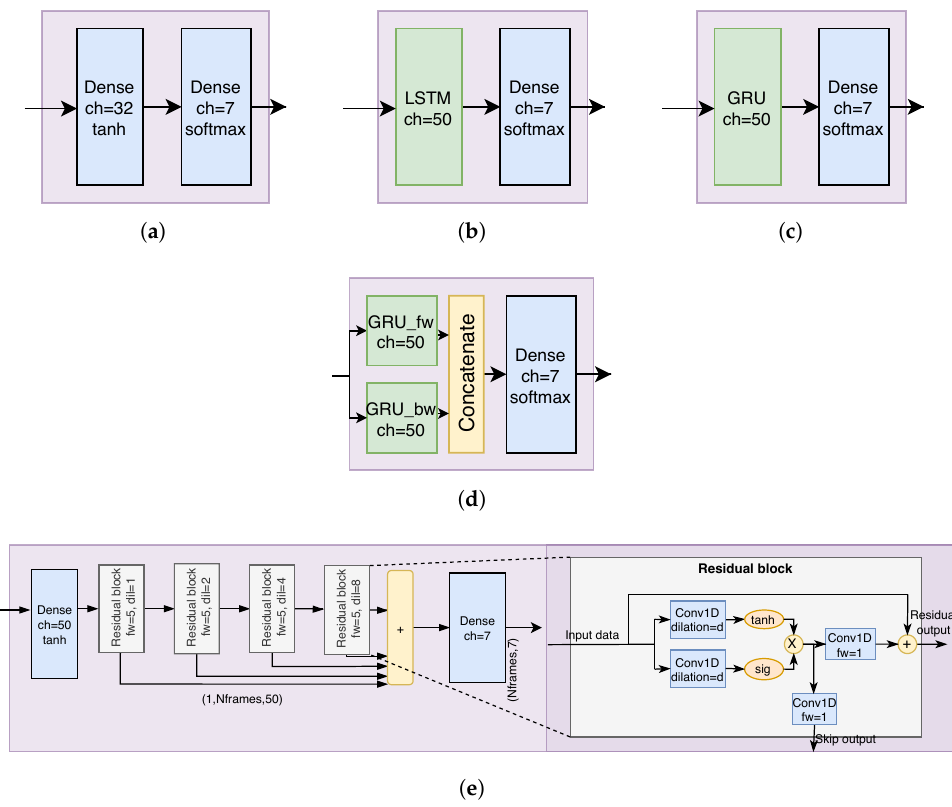
Figure 4. Compared time series module architectures. ( a ) Dense time series model; ( b ) LSTM time series model; ( c ) GRU time series model; ( d ) BGRU time series model; ( e ) WaveNet time series